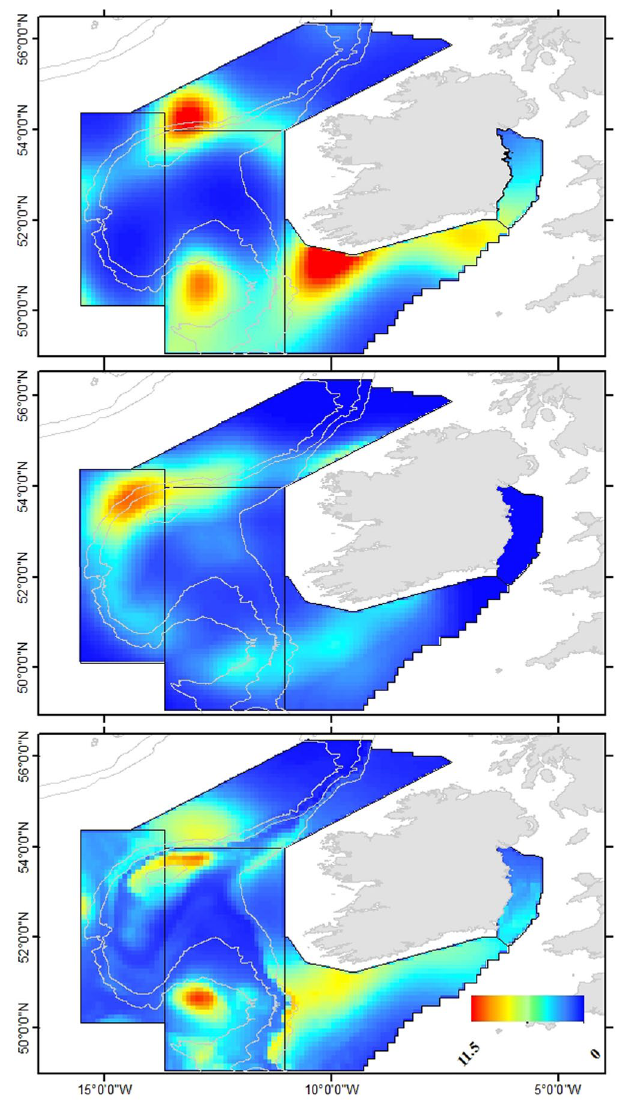
Figure 4. Density surface models for ( a ) summer survey data ( b ) winter survey data and ( c ) combined summer and winter data. Red colours indicate high density, dark blue colours indicate low density. Map generated using ArcGIS 10.2.